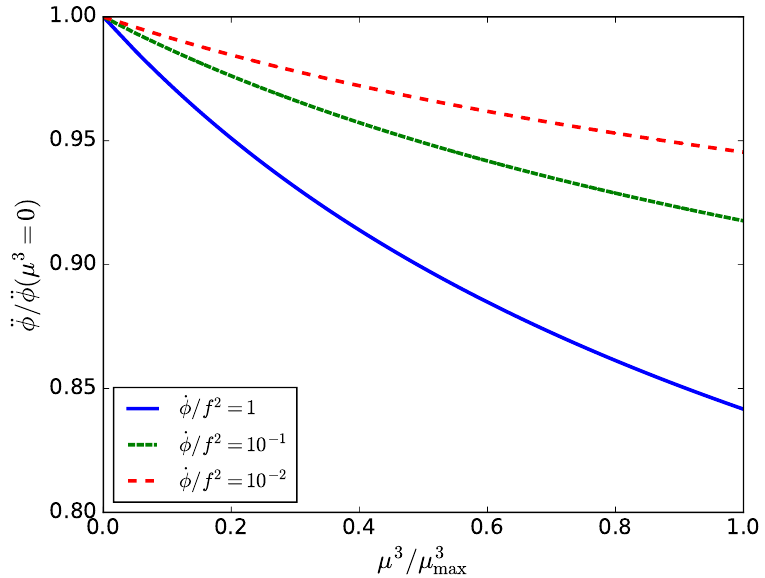
Figure 8 . The ratio between (cid:127) (cid:30) with non-zero slope (cid:22) 3 (eq. (3.30)) and (cid:127) (cid:30) with (cid:22) 3 = 0 (eq. (3.24)). We take H = 0 in this